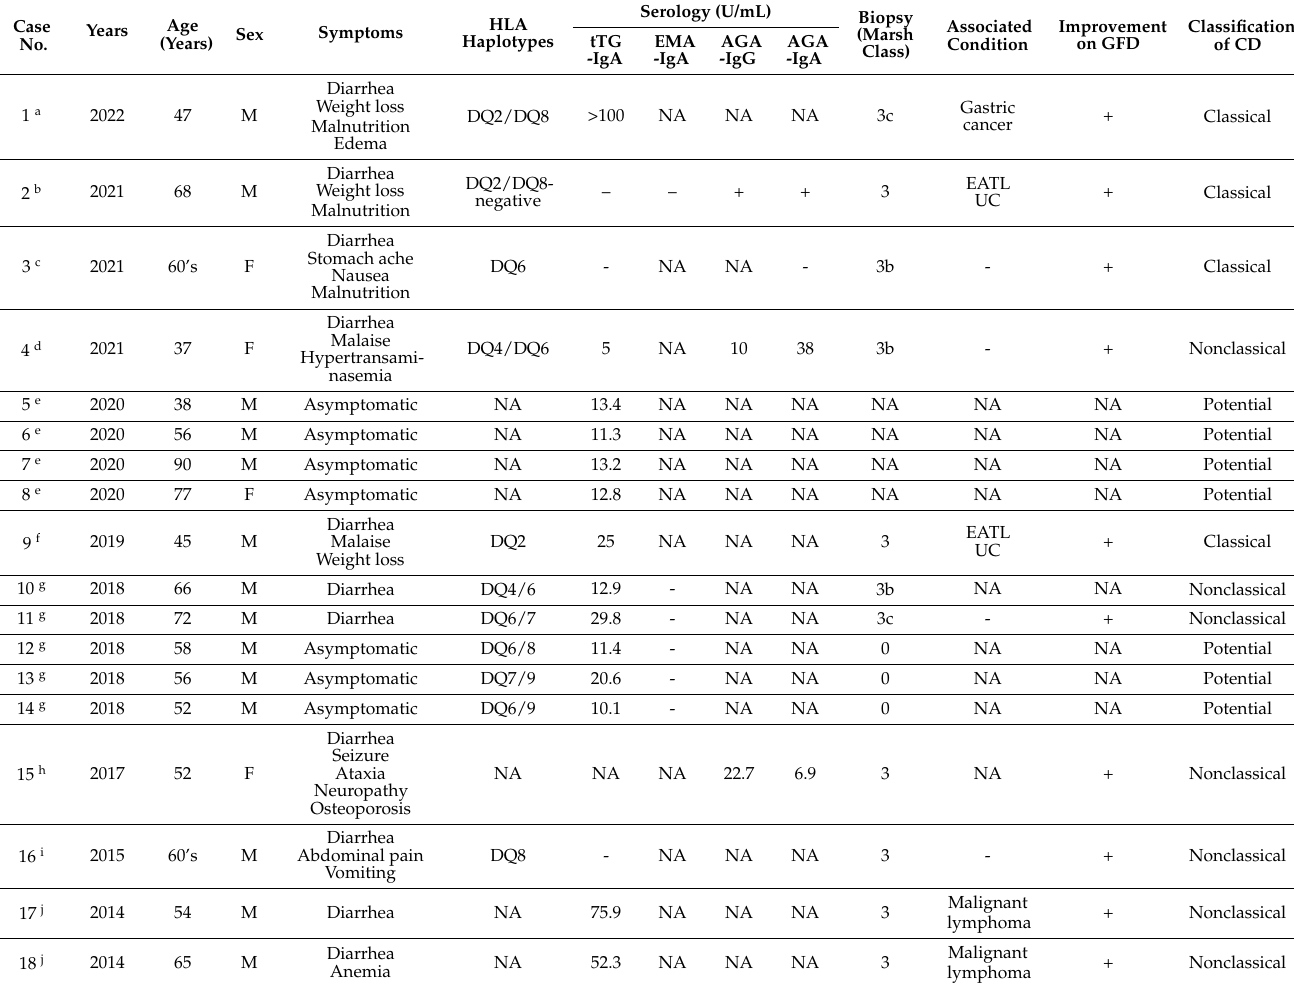
Figure 1. Immune reactions involved in gluten-related disorders. Gluten-related disorders are classified into three categories: autoimmune, allergic, and neither allergic nor autoimmune. Autoimmune disorders include celiac disease, dermatitis herpetiformis, and gluten ataxia. Allergic disorders are food allergy to wheat. Although the pathogenesis of nonceliac gluten sensitivity is not fully understood, it is considered to be nonautoimmune and nonallergic. The figure was created with reference to Sharma et al. and Taraghikhah et al. [1,2]. Table 1. The literature on cases of celiac disease and seropositivity in Japan.